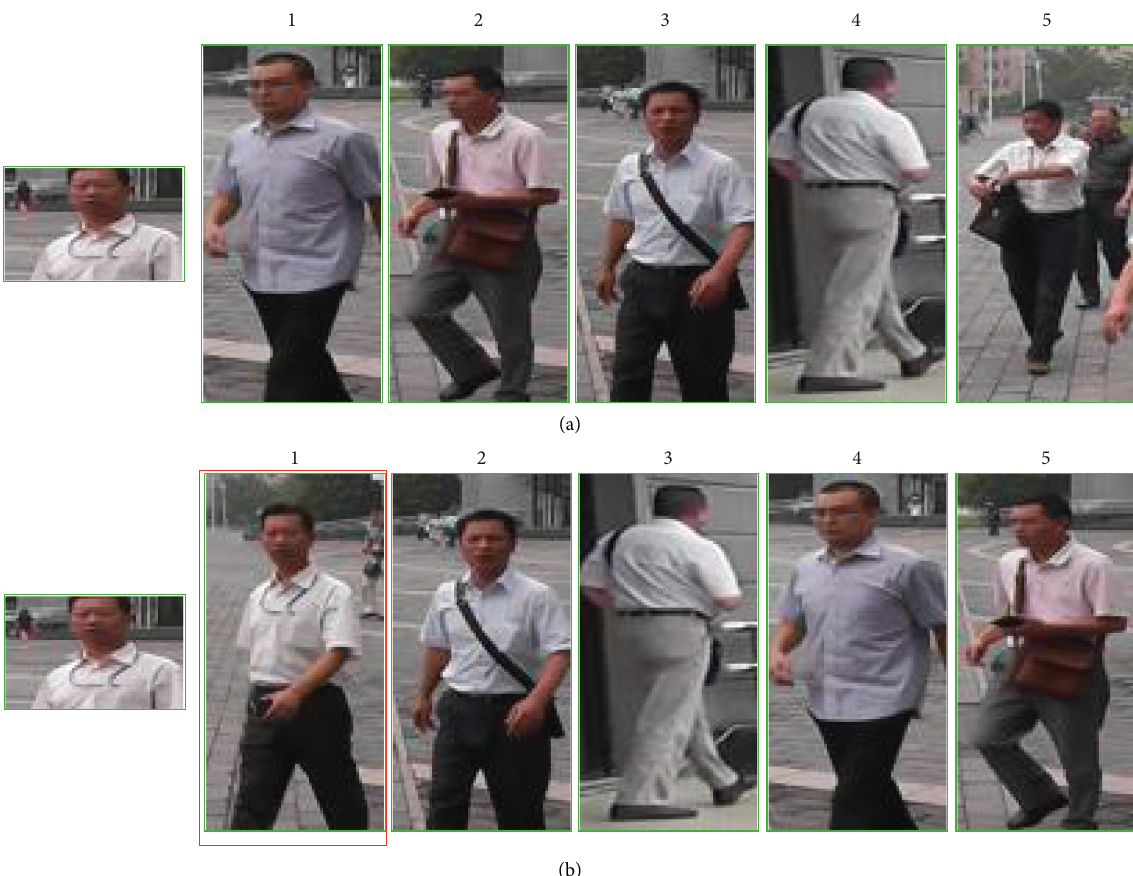
Figure 5: Example of retrieval results. (a) Literature. (b)